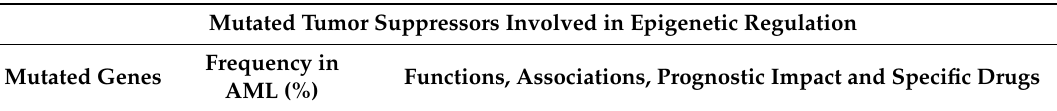
Table 2. Summary and features of AML mutated tumor suppressors involved in epigenetic